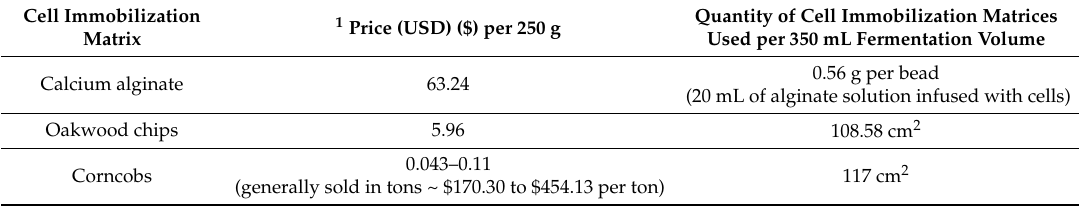
Table 2. Cell immobilization matrices used in the study and their sale price.